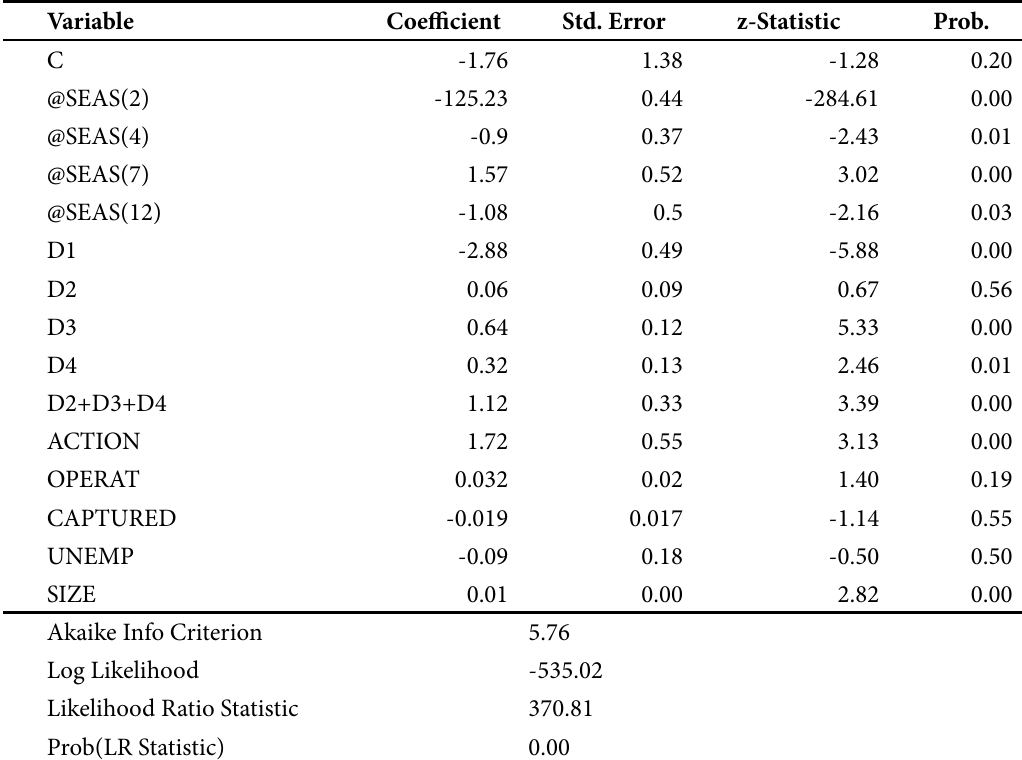
Table 3: Negative Binomial Model Results for PKK initiated